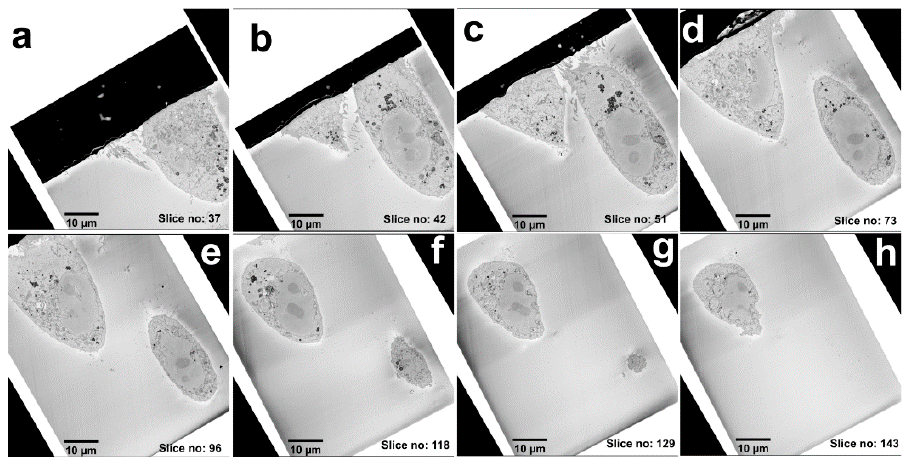
Figure 2. A collage of multi-plane images from the SB-EM 3D series. ( a – h ) Images from the 3D EM stack acquired from the selected cells are shown in the increasing order of the z -axis. The distance between the slices is 50 nm.